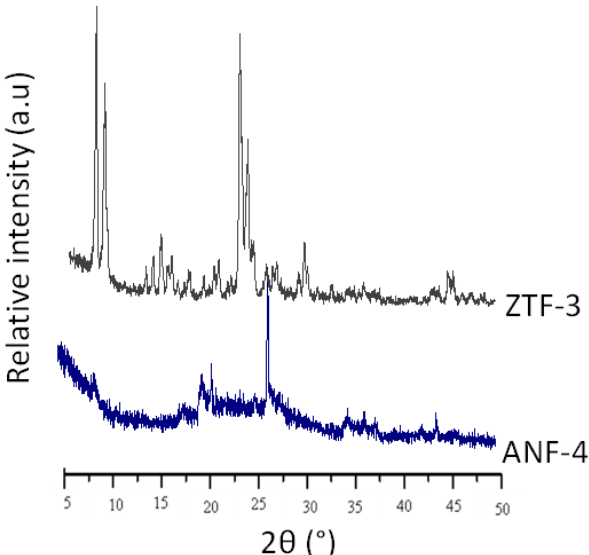
Figure 6. XRD pattern of aluminosilicates and ZSM-5 impregnated by Fe 3+ .